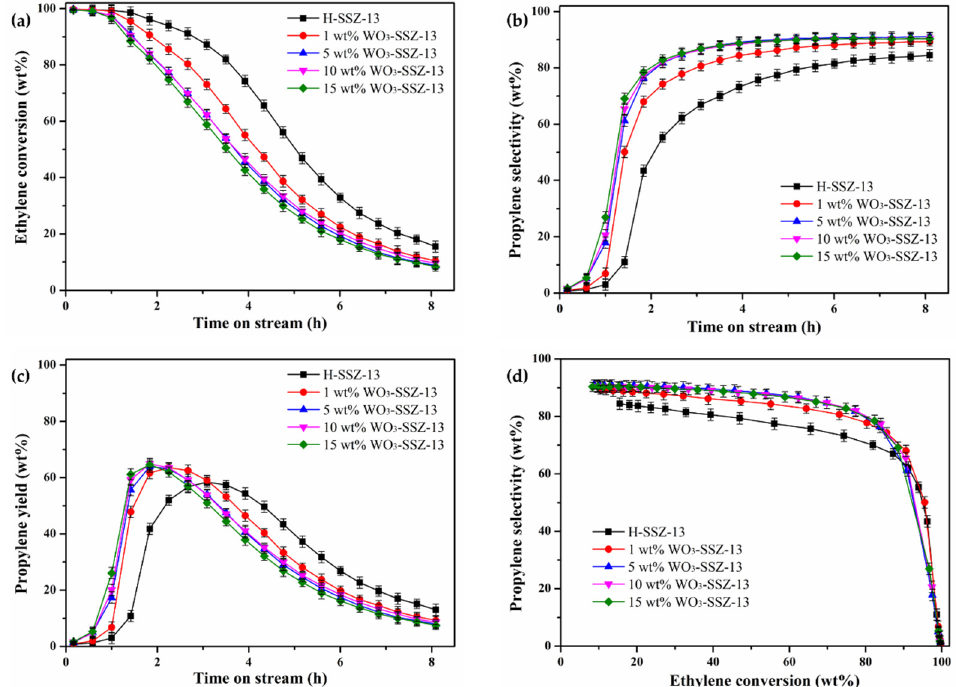
Figure 2. Results of ETP reaction over H-SSZ-13 and WO 3 -SSZ-13 samples. ( a ) Ethylene conversion, ( b ) propylene selectivity, and ( c ) propylene yield as a function of time on stream; ( d ) propylene selectivity against ethylene conversion.